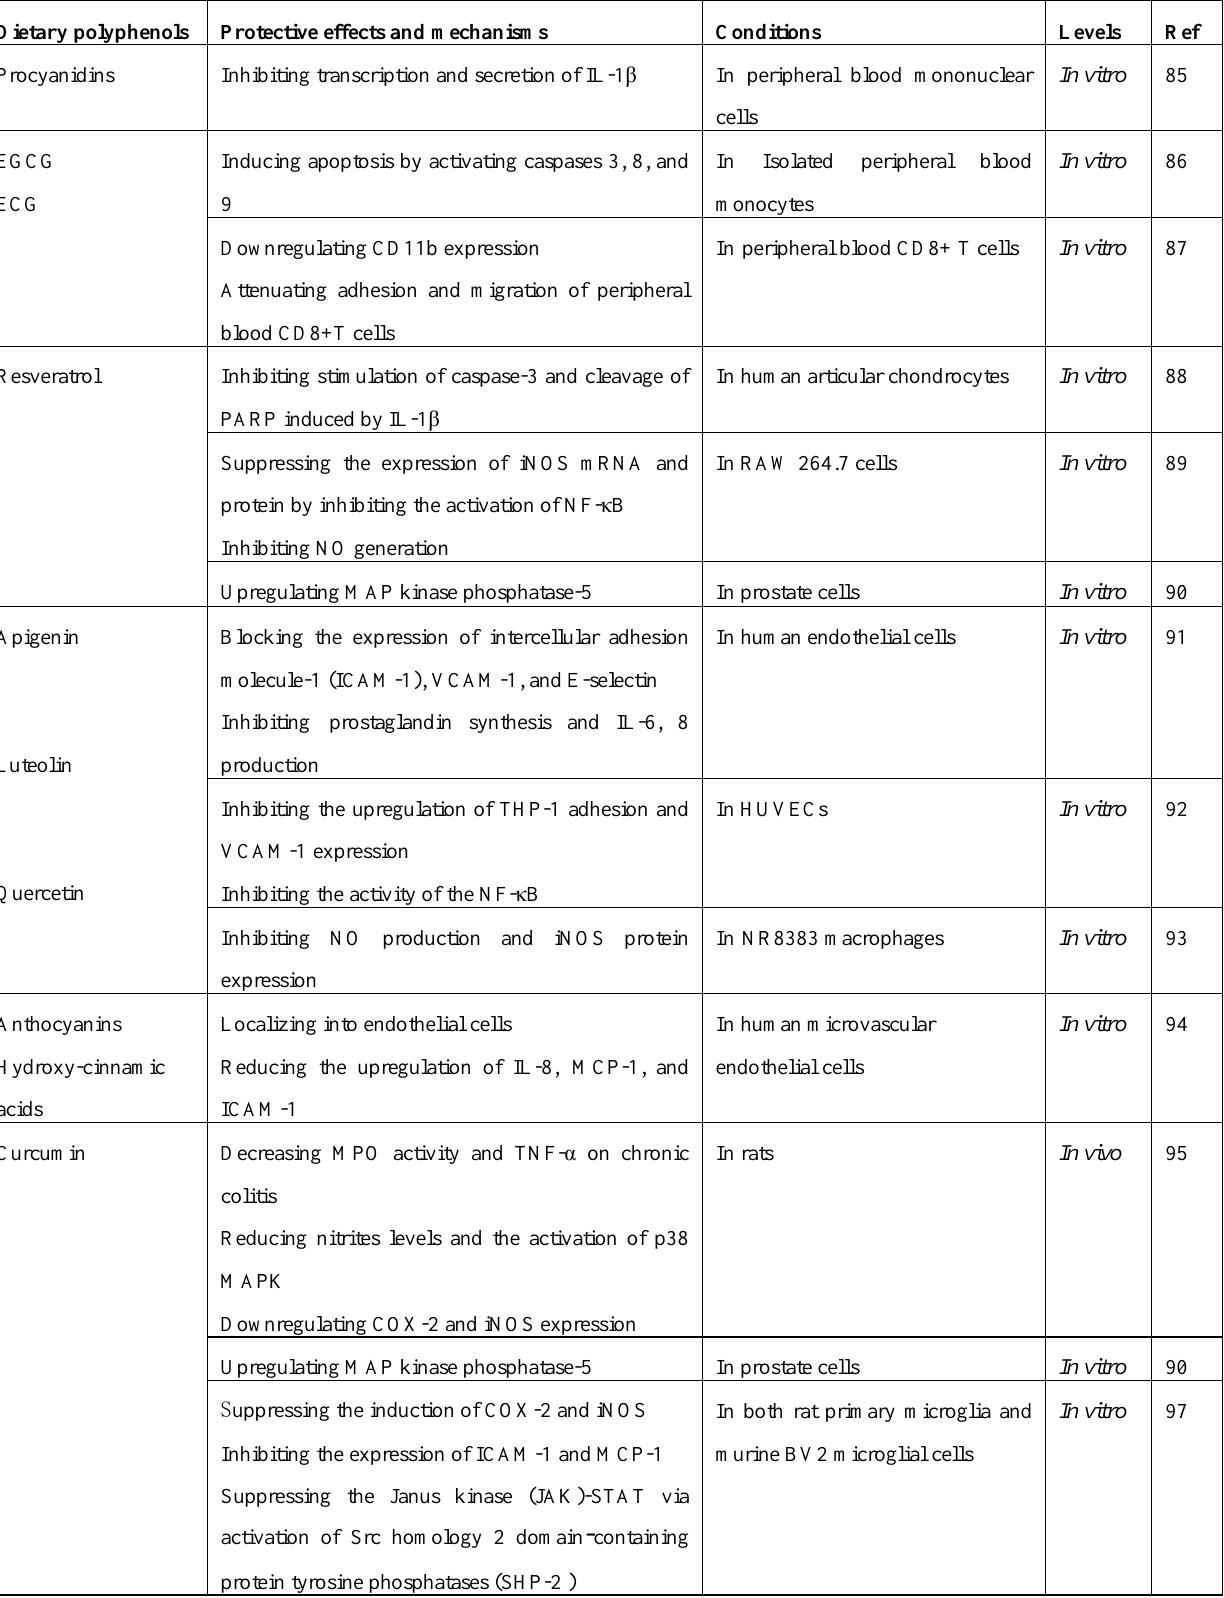
Table 5. Anti-inflammatory effects of dietary